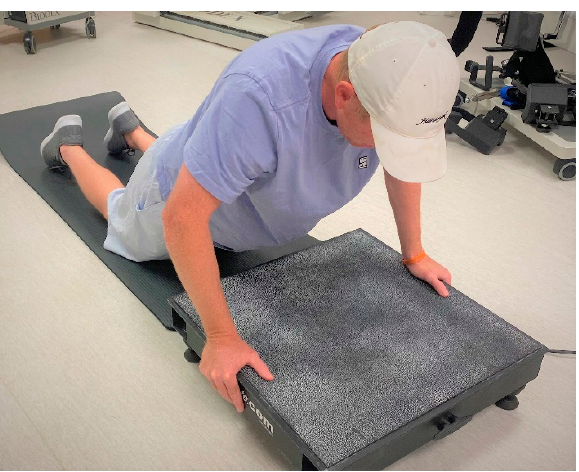
Figure 2. Semi push-up and hand positioning on the whole-body vibration platform